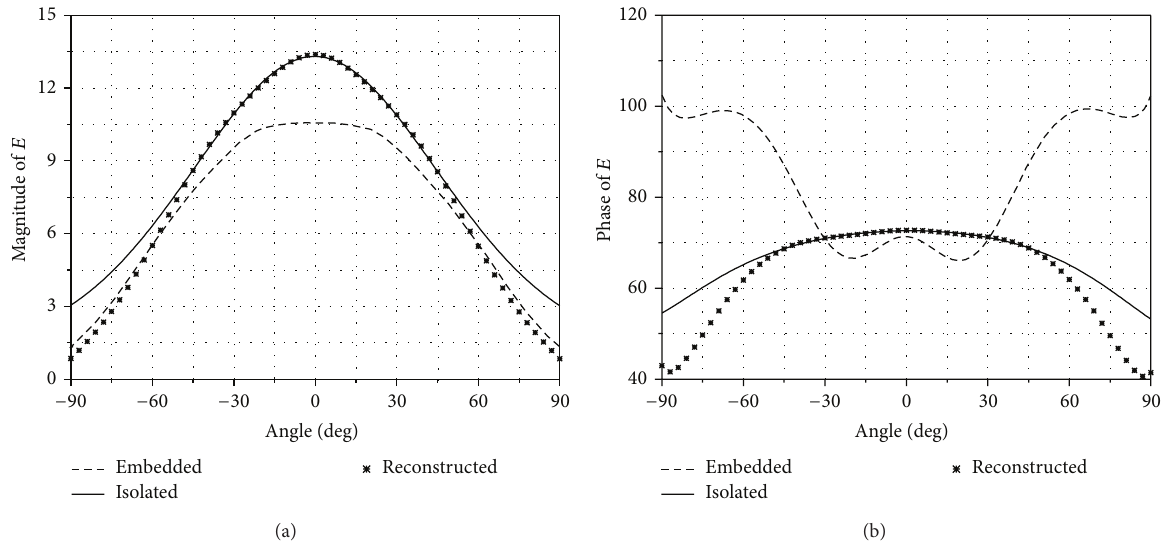
Figure 2: Magnitude and phase of 𝜃 component of the electric field in three cases for the linearly polarized microstrip array.